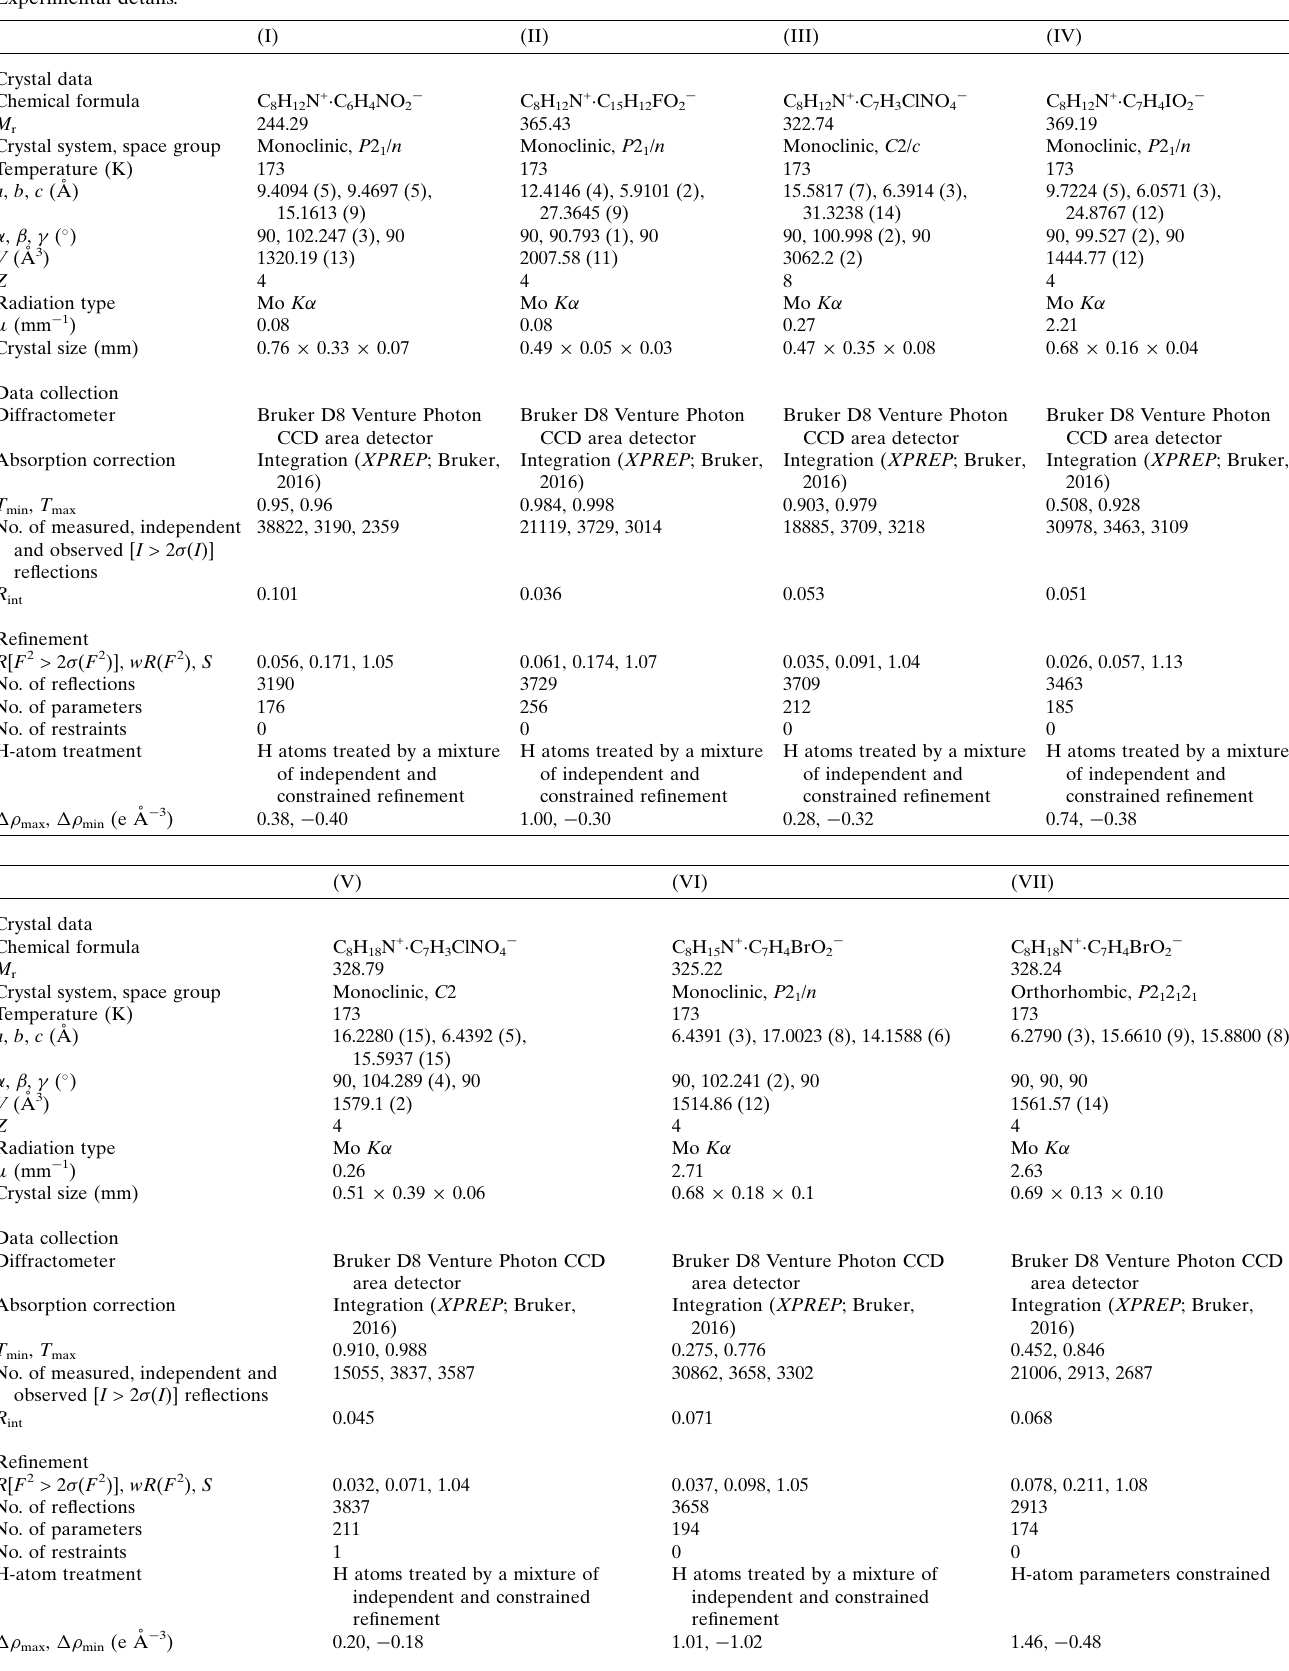
Table 8 Experimental